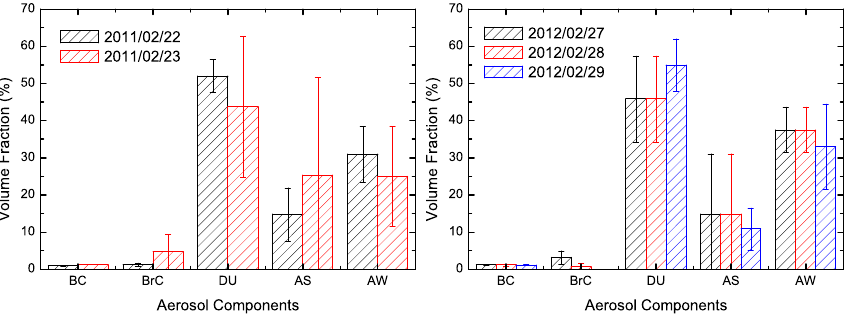
Fig. 10. Daily average percentage of aerosol chemical composition (BC, black carbon; BrC, brown carbon; DU, mineral dust; AS, ammonium sulfate-like component; AW, aerosol water content) retrieved during haze days of 2011 (left) and 2012 (right).